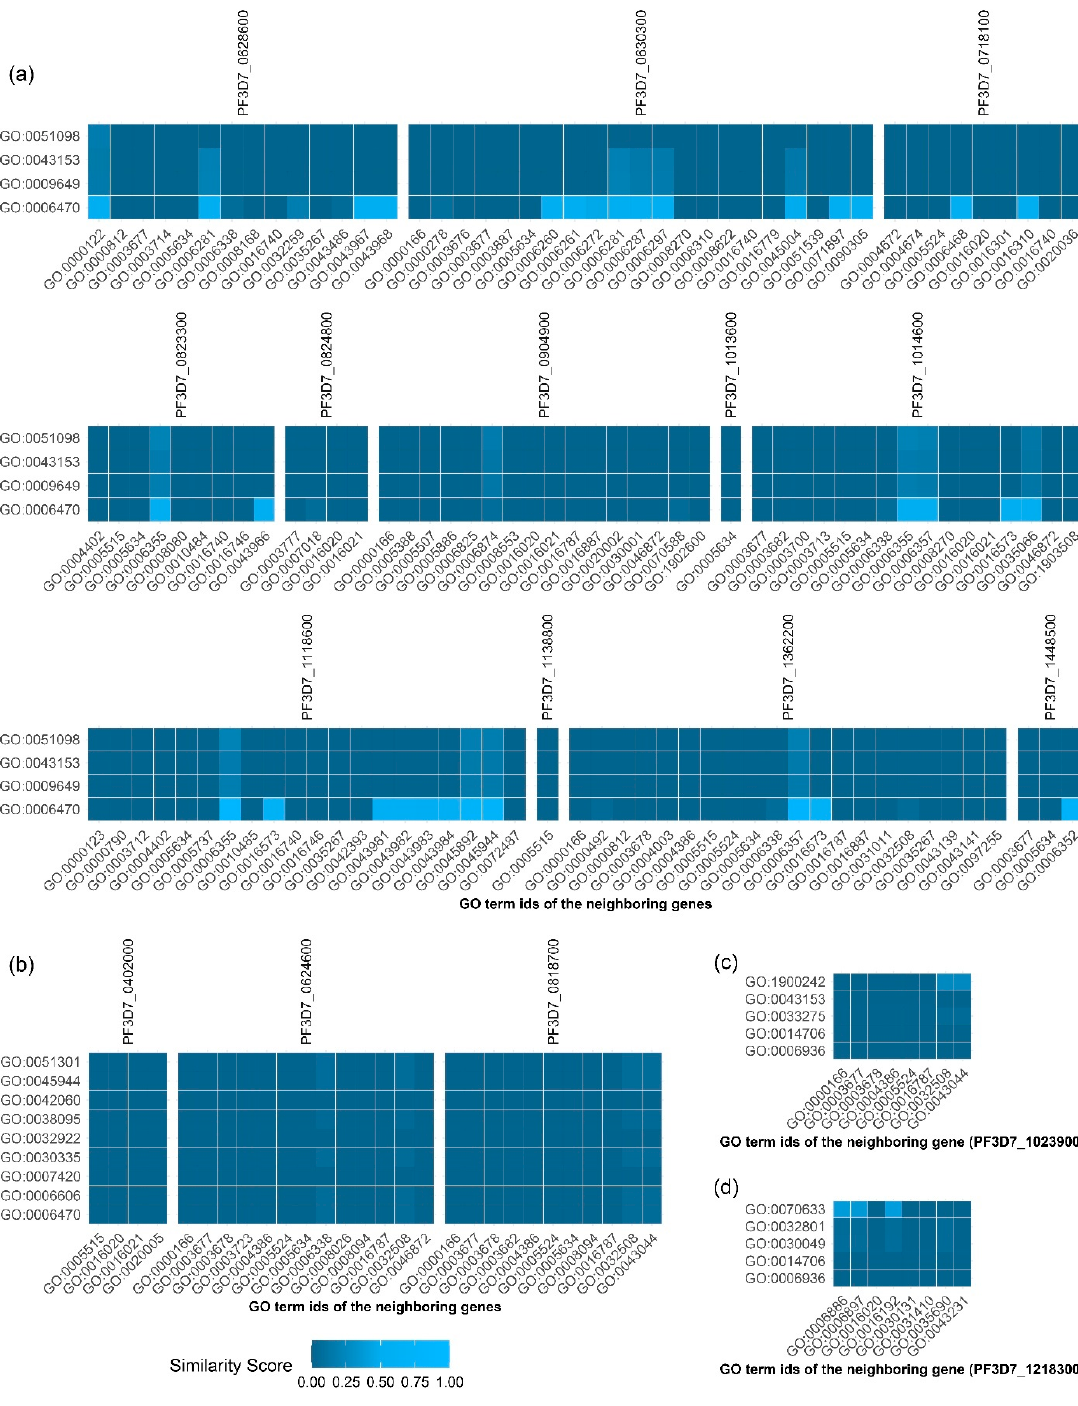
Figure 4. The similarities of the GO terms of four unknown function genes, including ( a ) PF3D7_1303800 , ( b ) PF3D7_1201000 , ( c ) PF3D7_1248700 , and ( d ) PF3D7_0401800 , plus the GO terms of their neighbors. The names of their neighboring genes are listed at the top of each block. The GO terms of the unknown function P. falciparum genes are listed on the y-axis, and the GO terms of their neighboring genes are listed on the x-axis. The heat map color reflects the similarity score, as indicated in the legend.